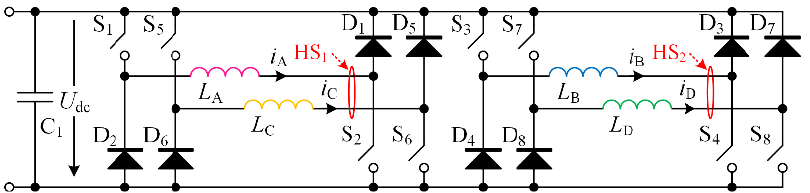
Figure 11. The baseline current detection scheme with two multiplexed hall effect sensors for the four-phase SRM.